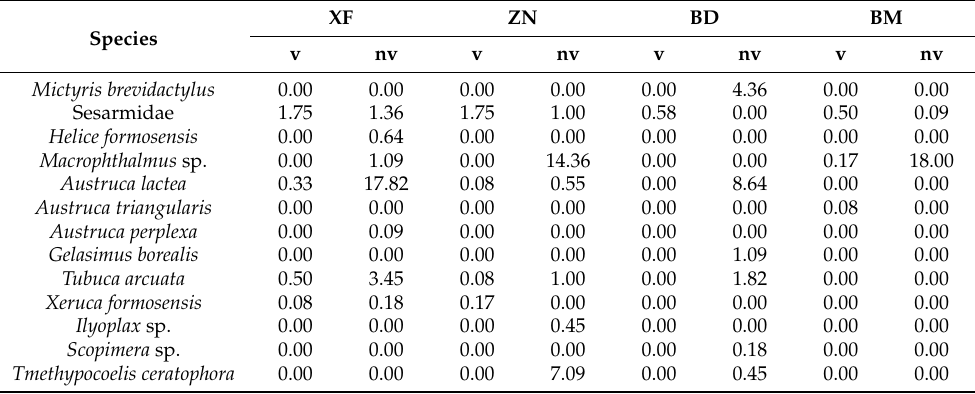
Table 3. Density of crab species (ind. m − 2 ) in the mangrove forests (v) and nonvegetated mudflats (nv) at the four sites on the western coast of Taiwan. The bold values indicate the most 2–3 dominant species in each